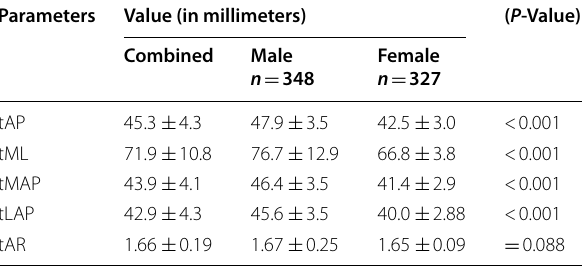
Values are presented as mean SD, * Significance was set at 0.05 as tested by ± student t -test for two independent samples.